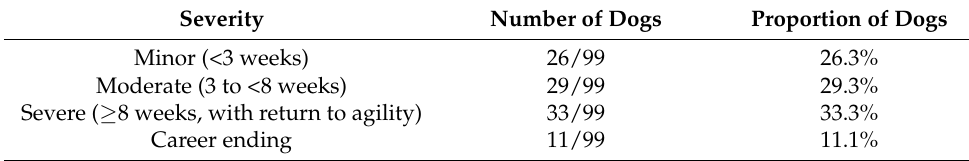
Table 7. Severity of the injury graded by recovery time to previous level in agility ( n = 99).